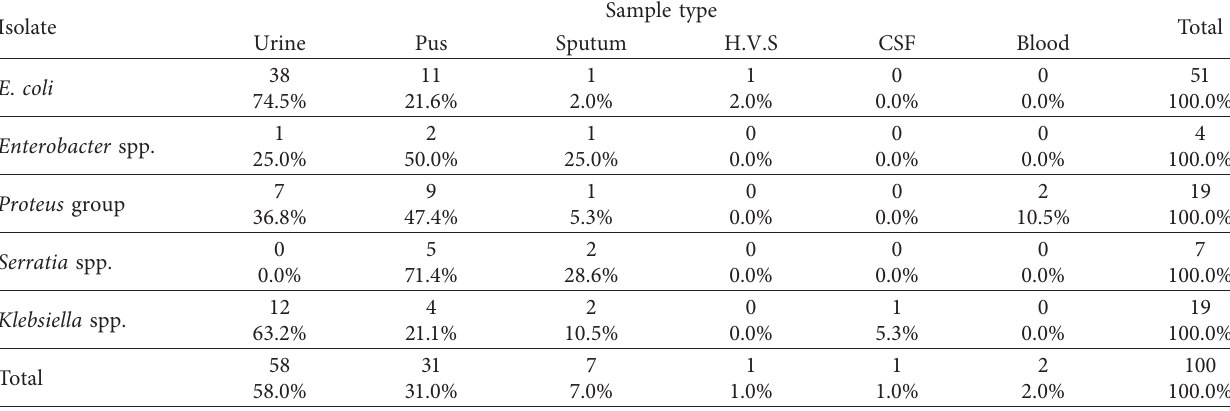
Table 2: Distribution of the isolates according to clinical sample type.